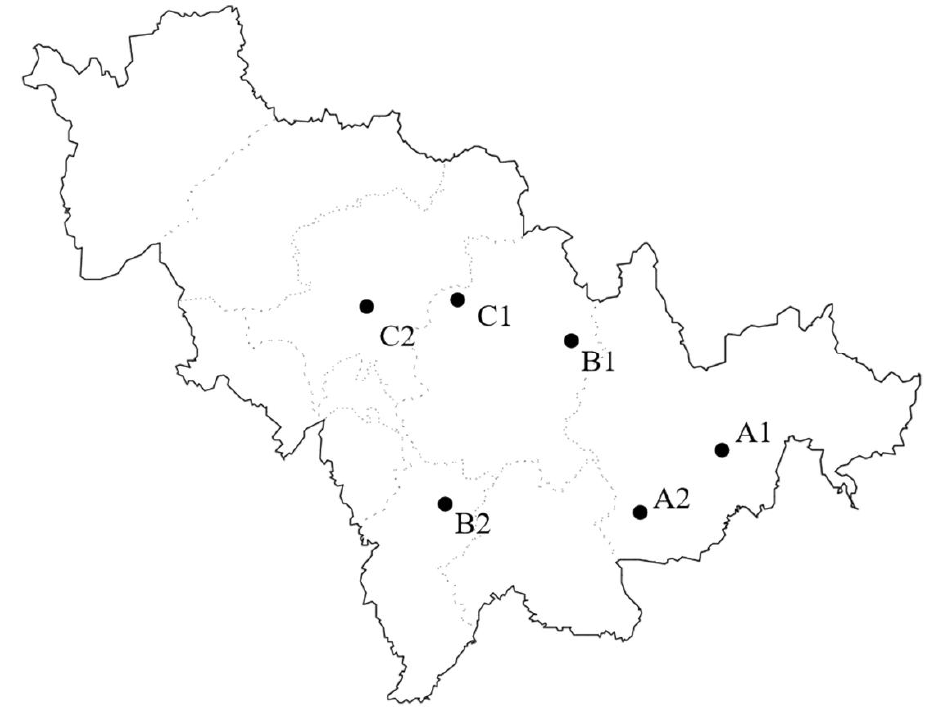
Figure 1. Distribution map showing the investigation sites in Jilin Province (A1: Quanshuidong For-